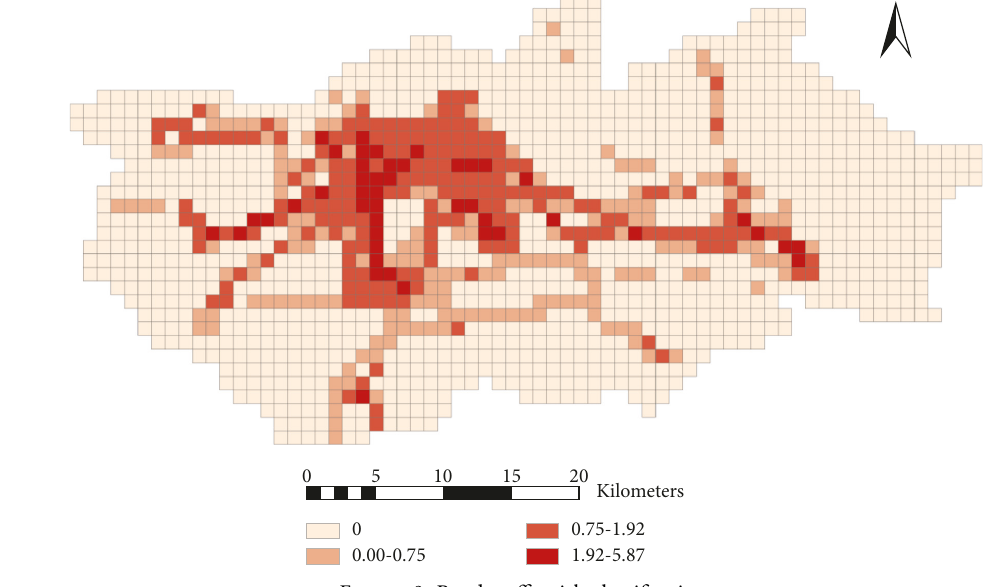
Figure 9: Road traffic risk classification. Table 3: The explanatory variables to be selected for the model.